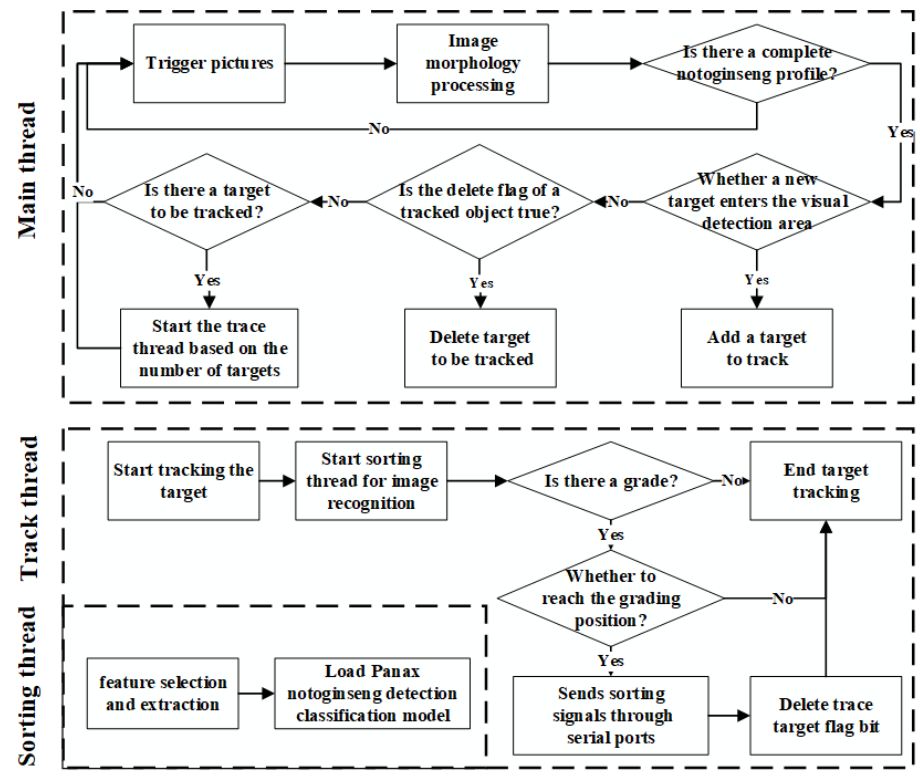
Figure 9. Flow chart of system software control